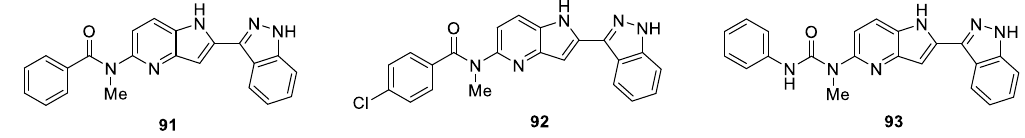
Figure 10. Chemical structures of 3-(pyrrolopyridin-2-yl)indazole derivatives 91 , 92 and 93 .